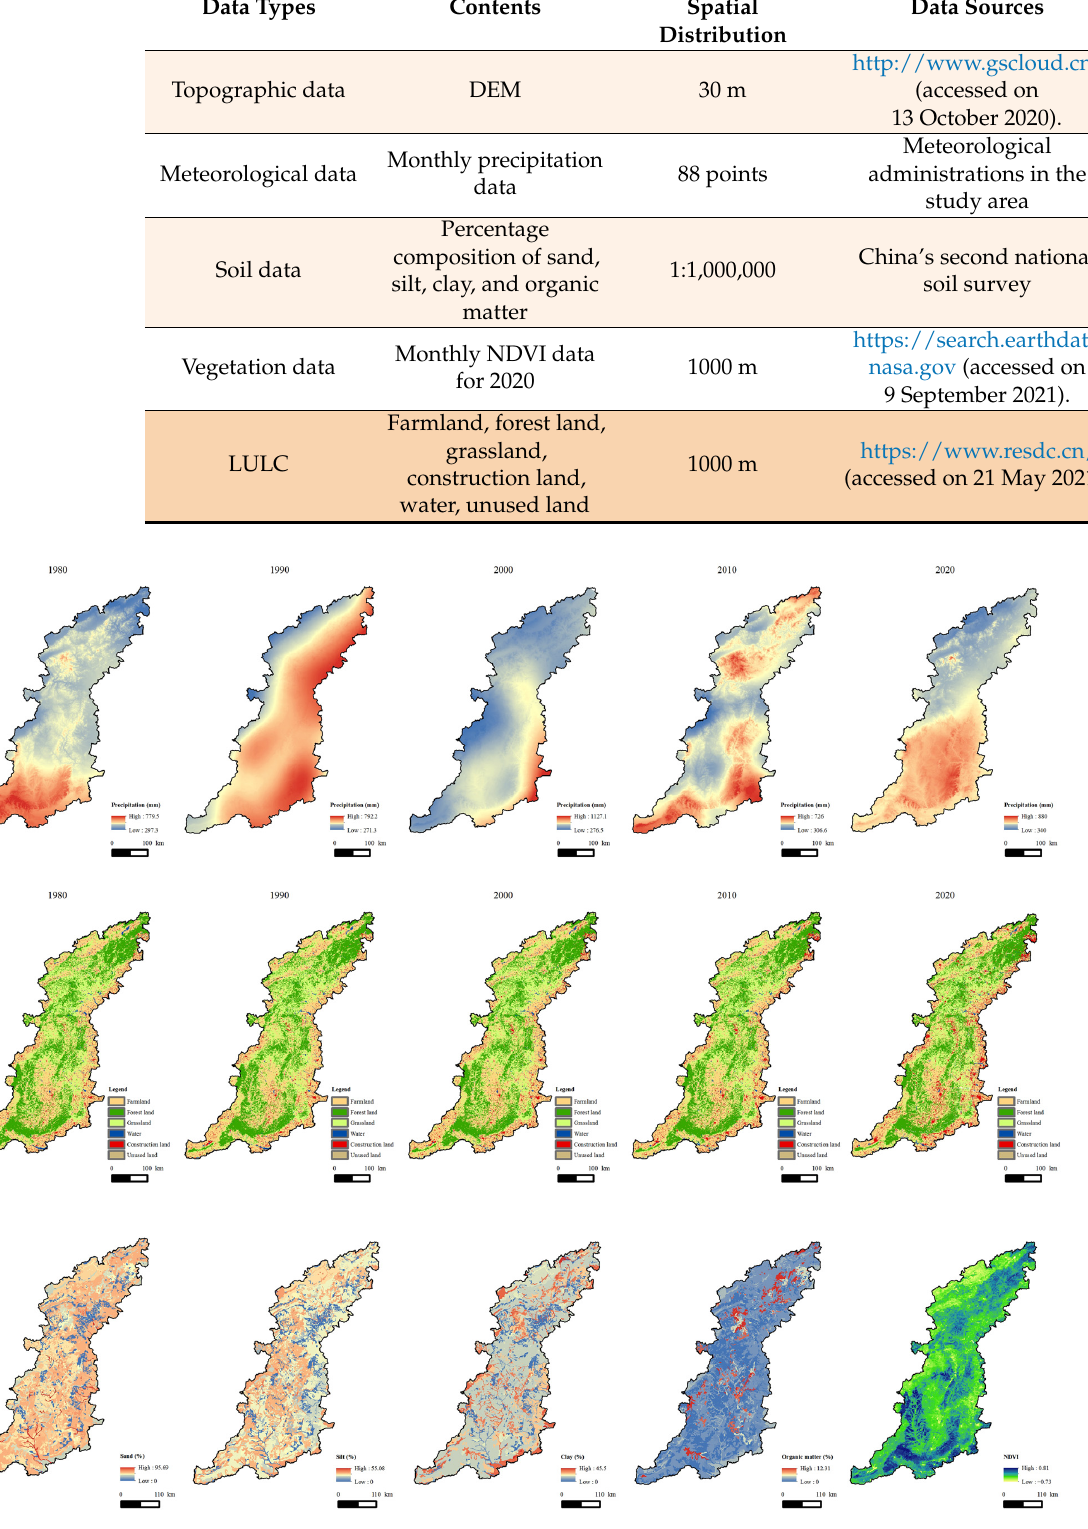
Figure 2. Data information used in this study. ( a ) Precipitation, ( b ) LULC from 1980 to 2020, and ( c ) soil texture and NDVI.